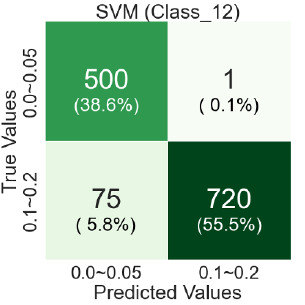
Figure 10. Confusion matrix of SVM-based classifier for